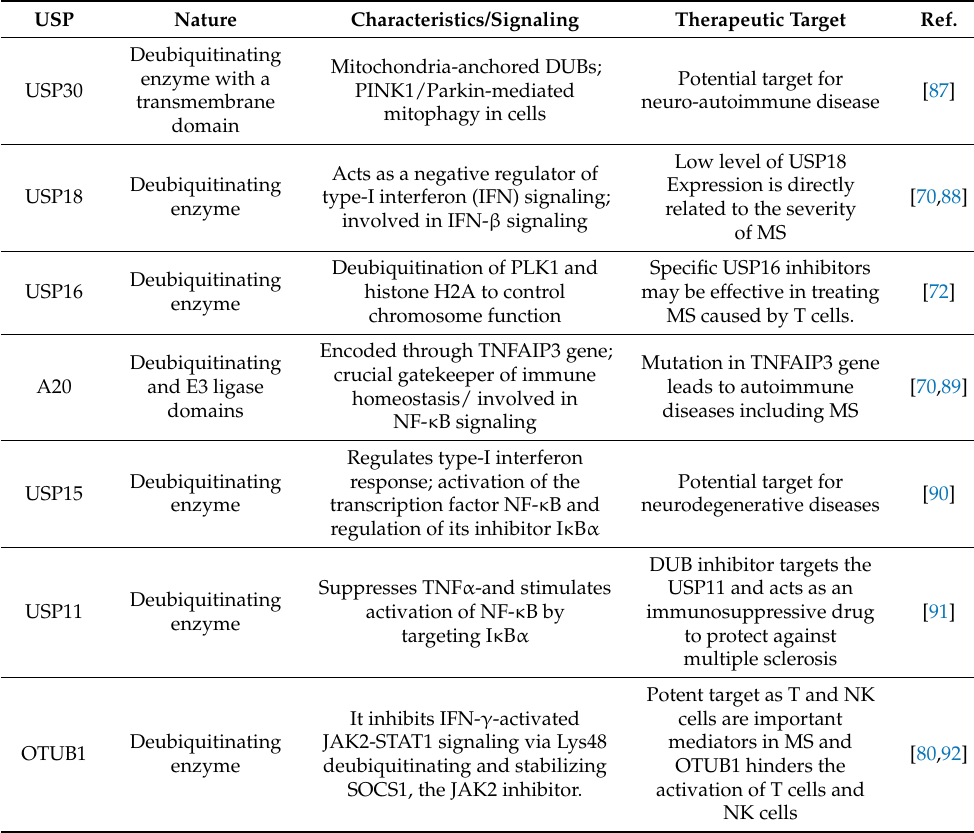
Table 2. Selected USPs targeted for neuro-autoimmune diseases. Nature